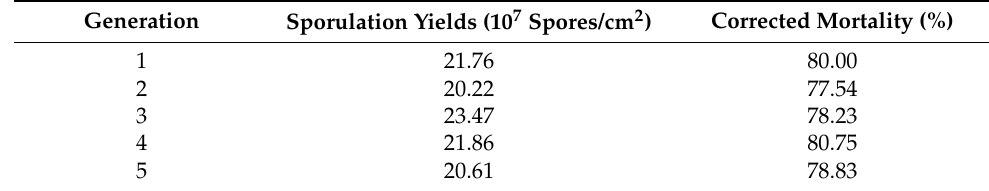
Table 5. Sporulation yields and corrected mortality of subcultured HBWB-44